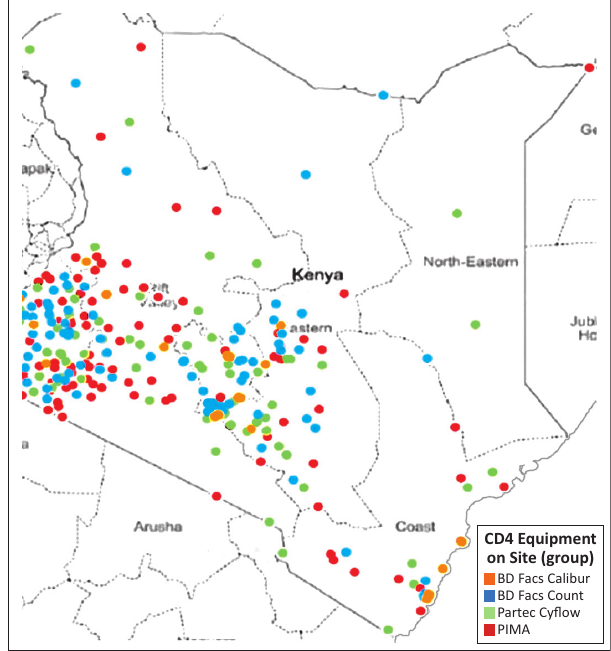
FIGURE 2: CD4 device mapping in Kenya. A total of 298 functioning CD4 instruments were clustered across 47 counties.